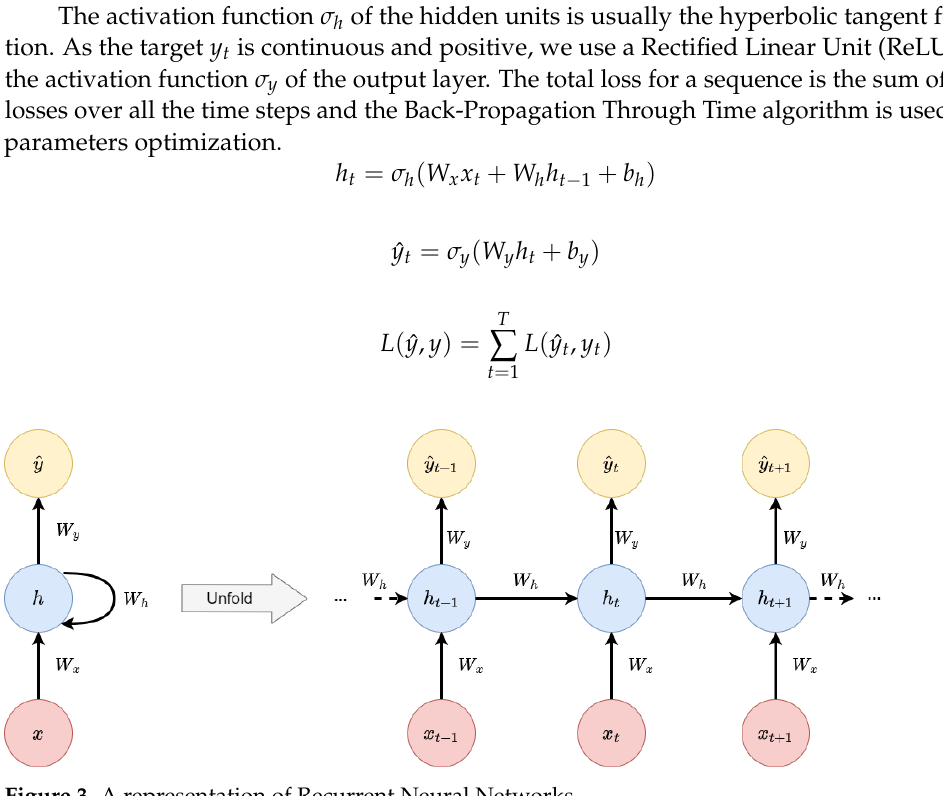
Figure 3. A representation of Recurrent Neural